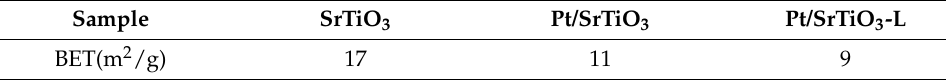
Table 2. The BET results of samples.